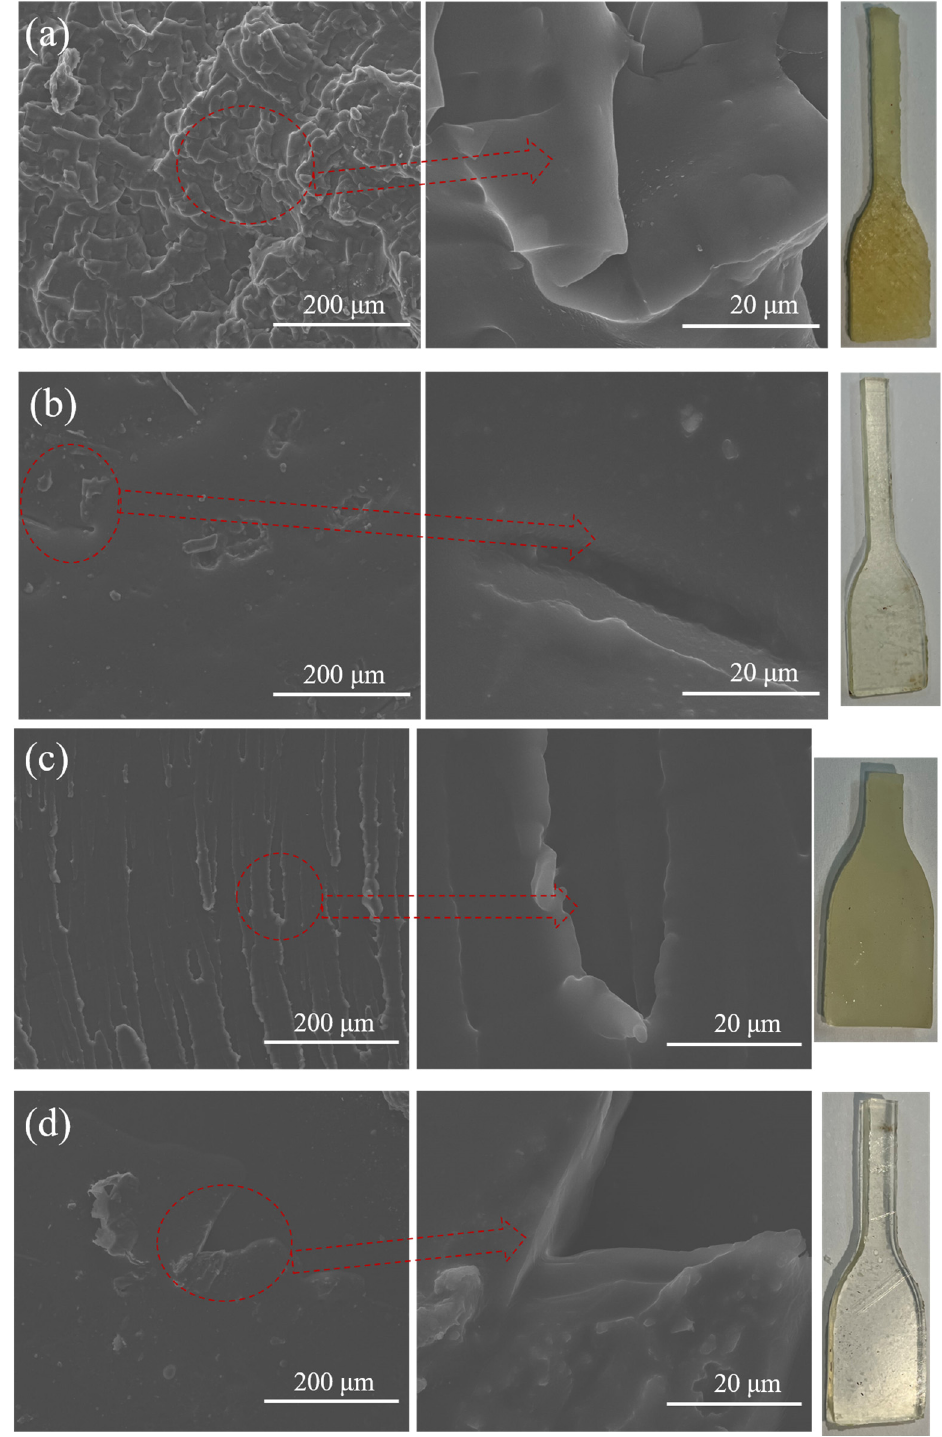
Figure 12. The SEM micrographs of the HTPE binders ( a ) HTPE/N-100, ( b ) HTPE/HDI, ( c ) HTPE/TDI, and ( d )